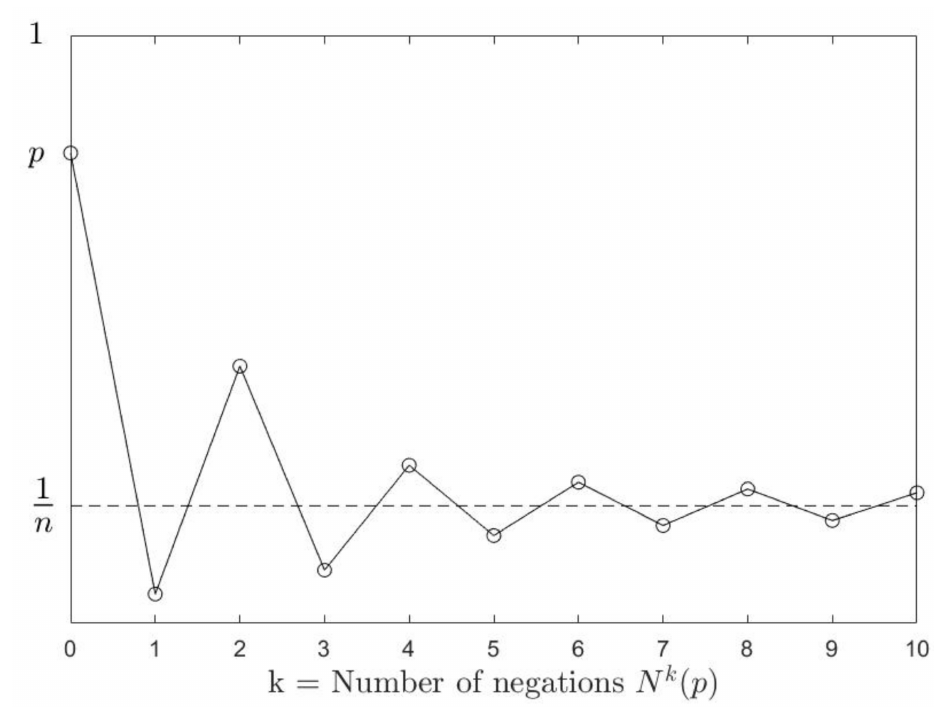
Figure 2. Contracting negator as a sequence of N k ( p ) with the limit 1